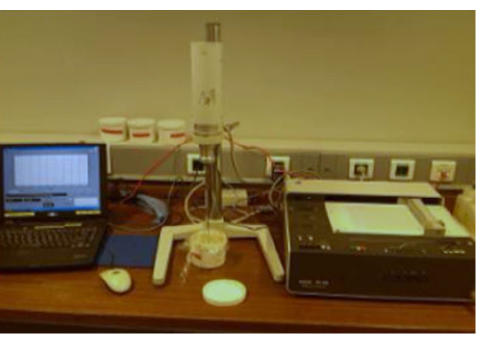
Figure 3. L chute. Figure 4. Rheometer detection.